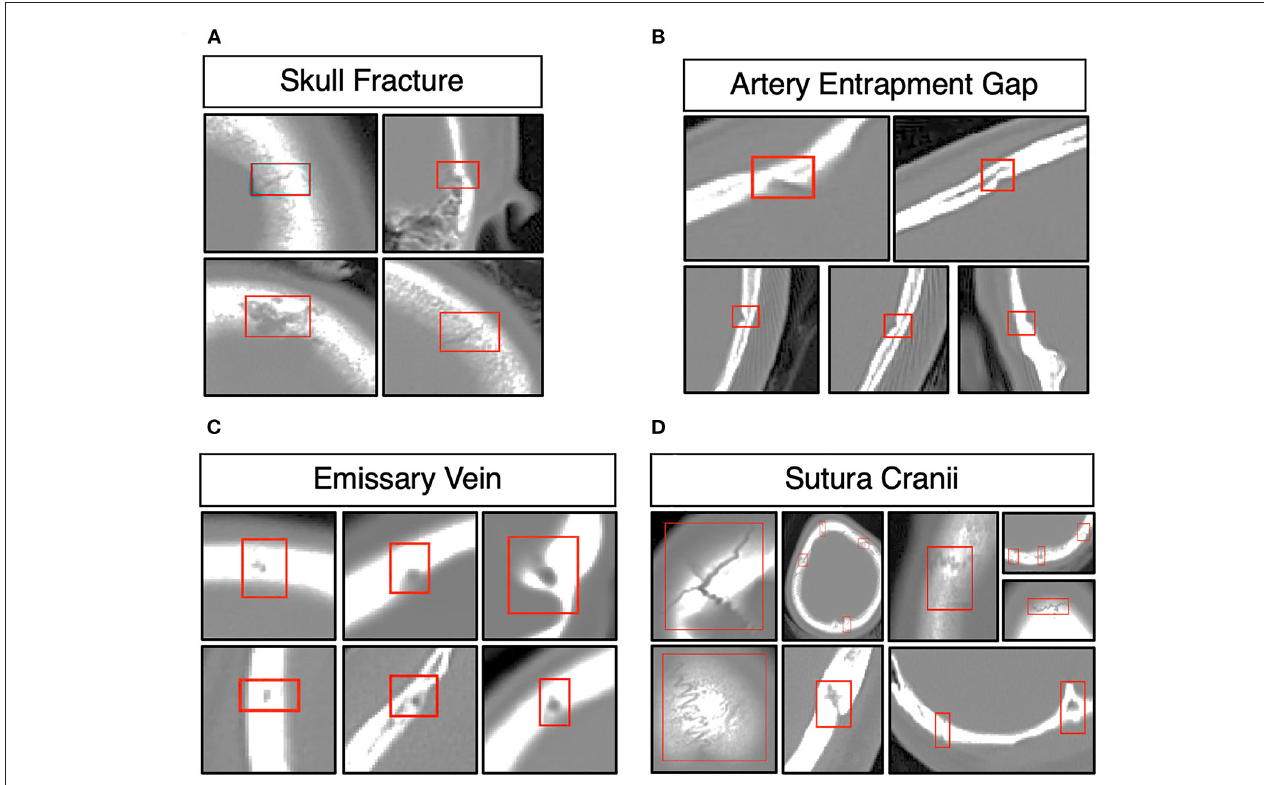
FIGURE 2 | Morphology of skull fractures and structures analogous to skull fractures. (A) Morphology of skull fractures in different positions and different fracture morphologies. (B) Skull fracture mimics the structure of the artery entrapment gap. (C) Skull fracture mimics the structure of the emissary’s vein. (D) Skull fracture mimics the structure of the sutura